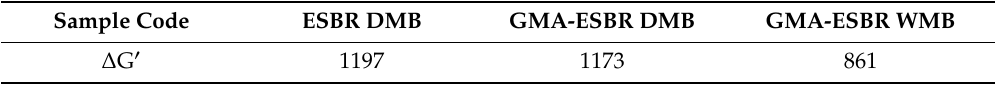
Figure 3. Storage modulus as a function of strain for the ESBR DMB, GMA-ESBR DMB, and GMA-ESBR WMB compounds. Table 6. The Payne e ff ect ( ∆ G (cid:48) ) of the ESBR DMB, GMA-ESBR DMB, and GMA-ESBR WMB